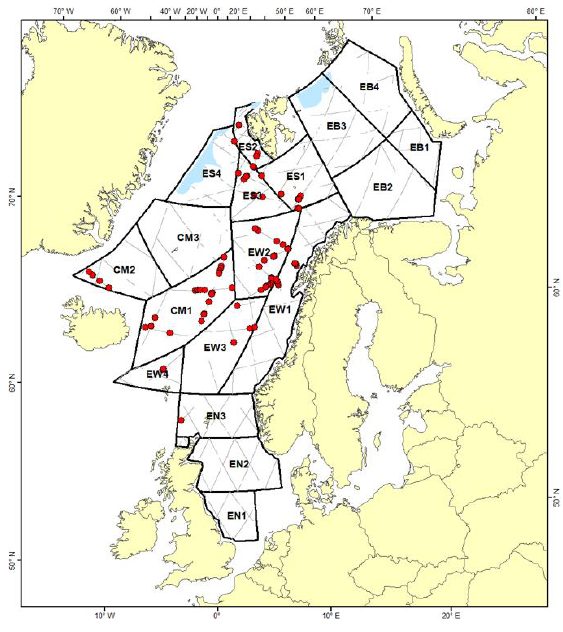
Figure 6. Distribution of sightings recorded as killer whales during the 2014-2018 sighting surveys. The blue areas represent ice